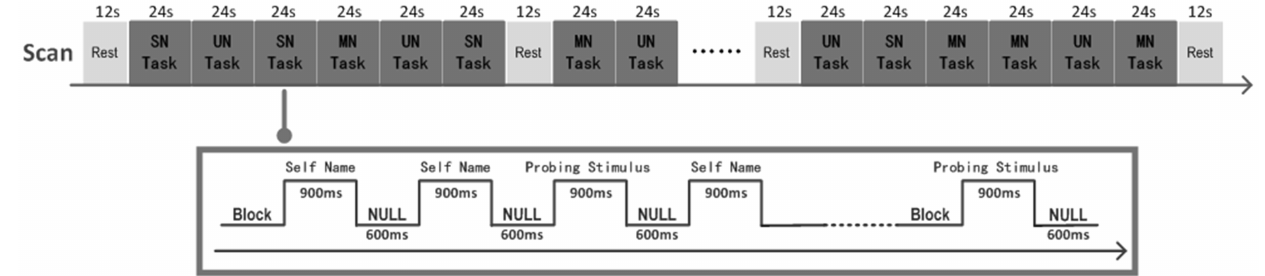
Table 1. Brain activations shown in various contrasts (p , 0.05, two-tail).